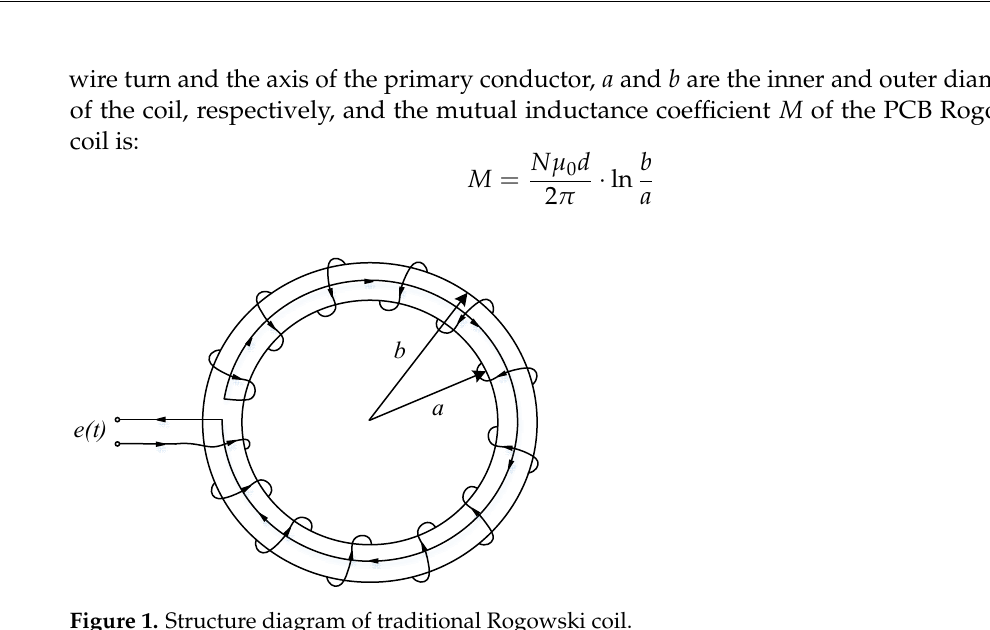
Figure 1. Structure diagram of traditional Rogowski coil.